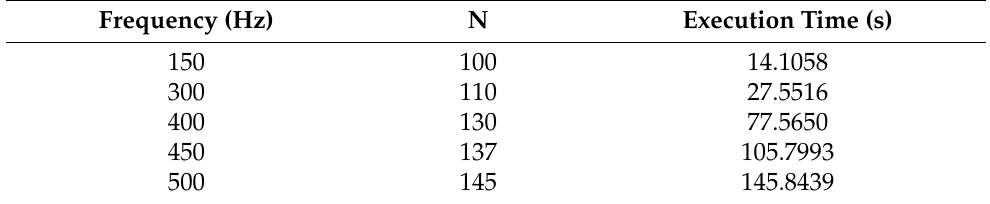
Table 4. The truncation order N and the execution time vary with the frequency of the sound